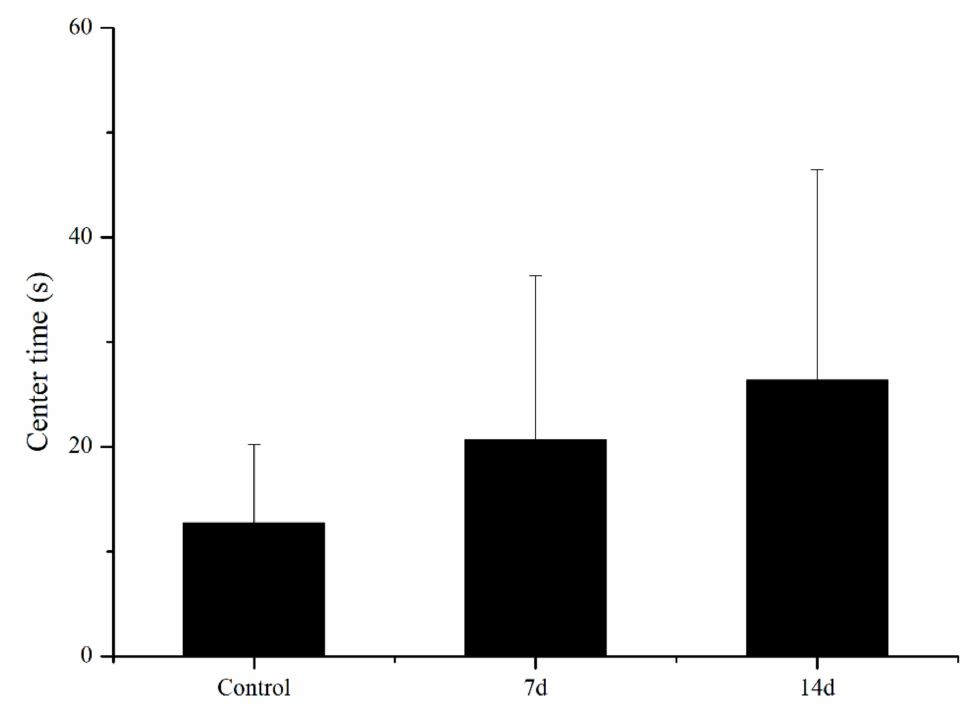
Figure 6. Effects of 7 and 14 days of the UCS protocol on center time in the rare minnow. Data are expressed as mean ± SE (n =